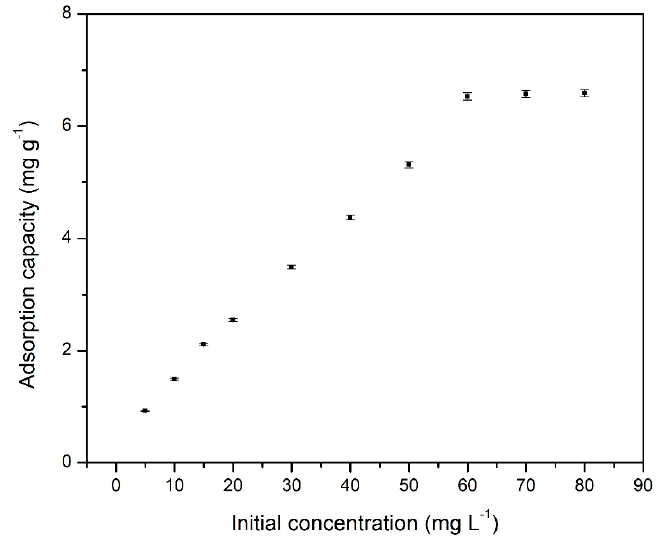
Figure 6. Influence of initial concentration for Pd(II) recovery on